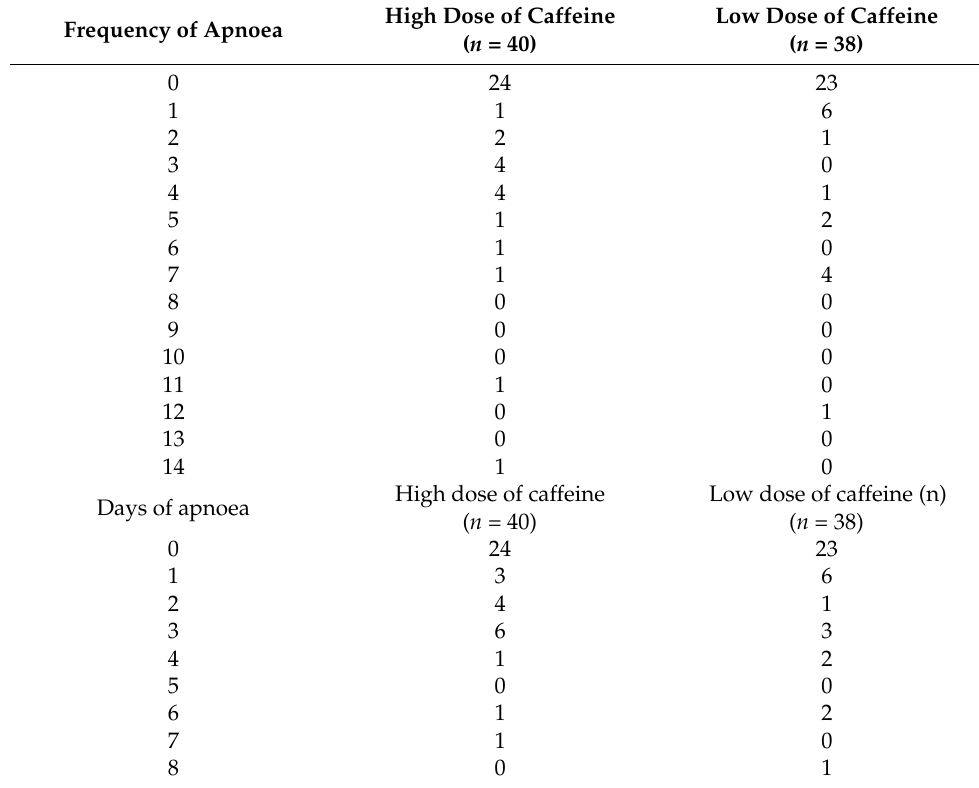
Table 2. Primary outcome ( n = 78).